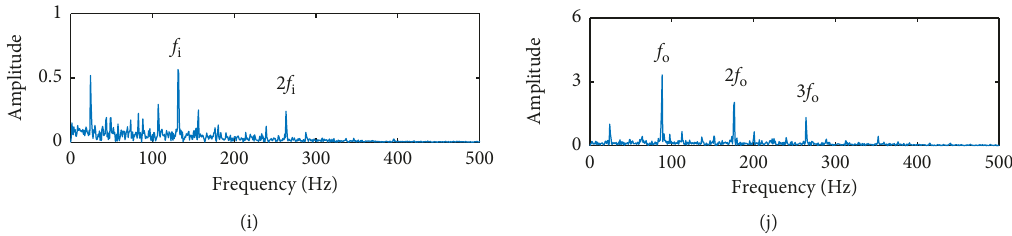
Figure 16: Diagnosis results of the compound fault experimental signal using the approach proposed in the paper: (a), (b) iteration curves for determining the optimal ARLW parameters; (c), (d) FS of the optimal ARLW for detecting the inner and outer ring defect information; (e), (f) TW of the filtered signal obtained by (c) and (d); (g), (h) FS of (c) and (d); (i), (j) ES of (c) and (d).